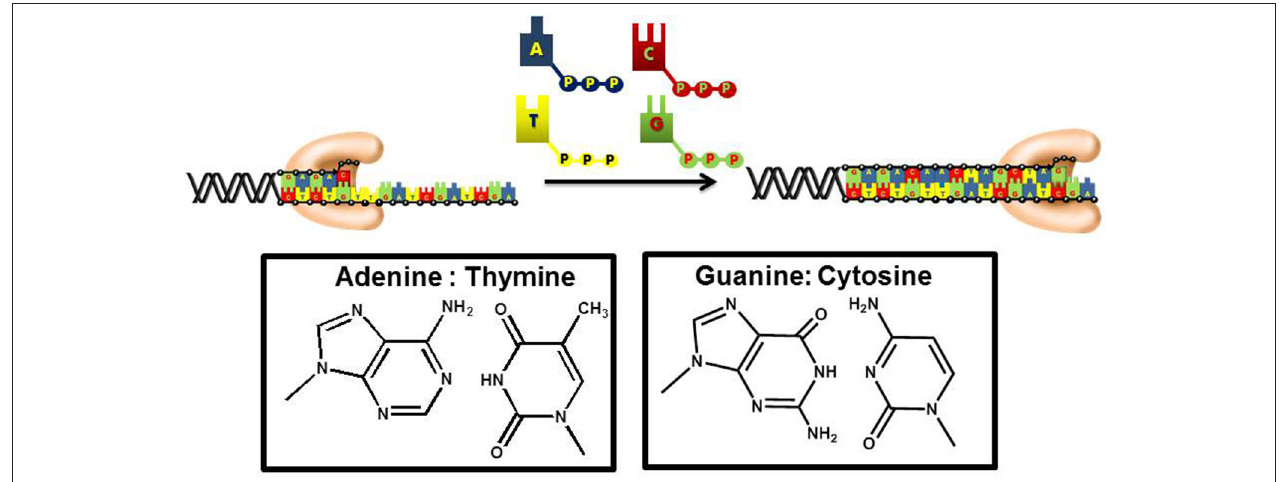
FIGURE 1 | DNA polymerases use a common mechanism to synthesize DNA. During the polymerization process, a nucleotide is covalently attached to the 3 ′ -OH group of a preexisting DNA chain serving as a primer. With most DNA polymerases, DNA is used as the template to guide each incorporation event. However, telomerase and other reverse transcriptases use or RNA as the template. Correct polymerization results in the synthesis of a DNA chain that is complementary to the template strand of